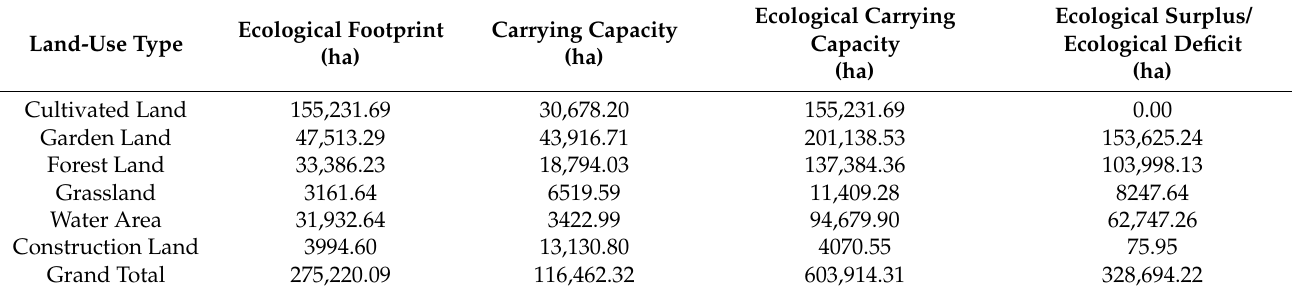
Table 12. Ecological carrying capacity and its state after